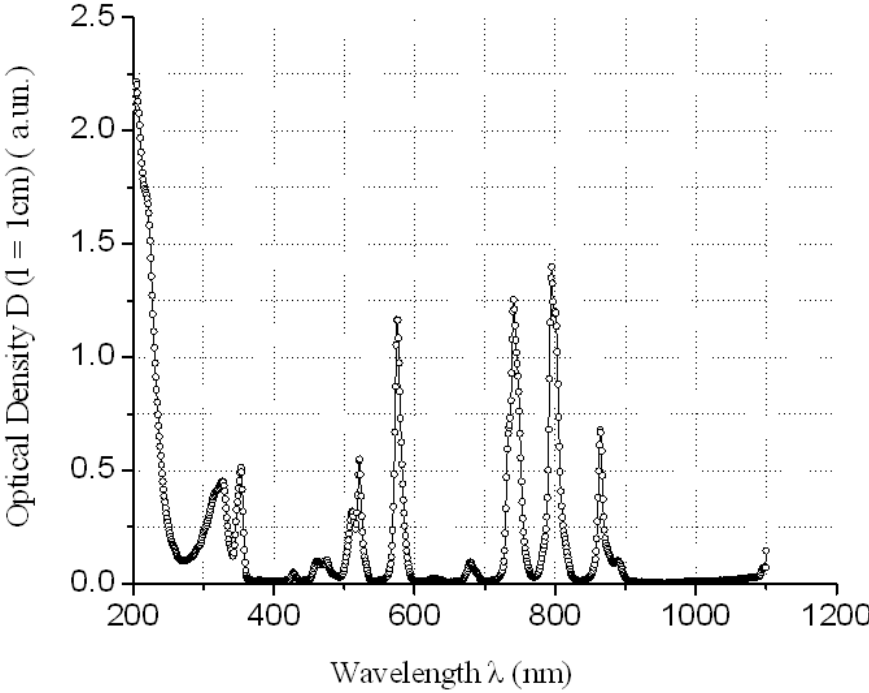
Figure 4. Electronic spectrum of water solution of NdCl 3 at concentration C NdCl3 ≈ 51.6 g/dm 3 relatively distilled H 2 O.